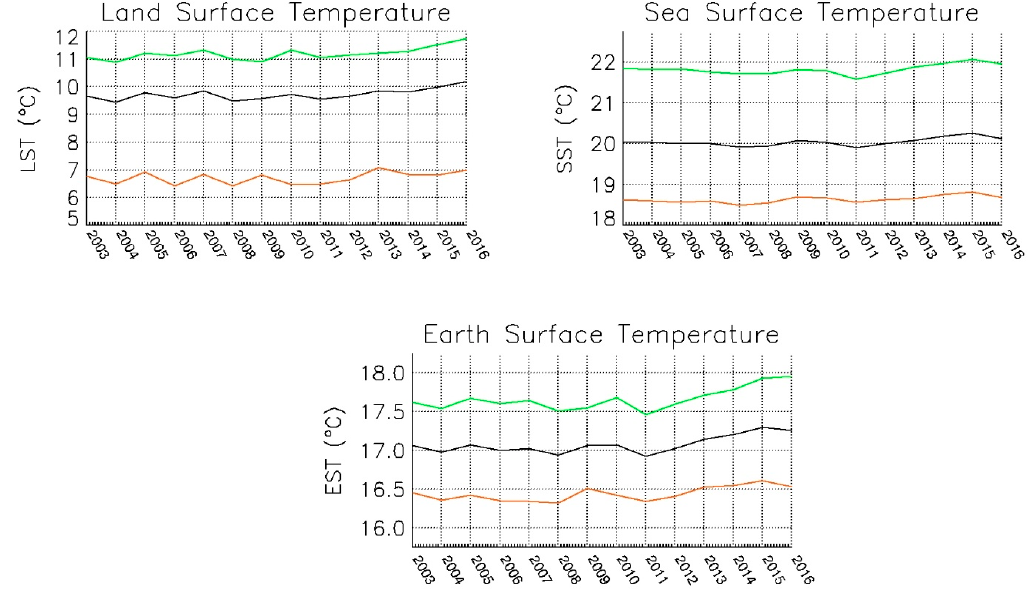
Figure 2. LST, SST and EST evolution in the NH (green) and SH (orange) and global (black) from 2003 to 2016. Notice how the highest temperatures are obtained for the EST, LST and SST in the NH and the lowest for the SH. Temperature keeps stable until year 2011, when a significant increase is from 2011 observed from 2011 onwards.